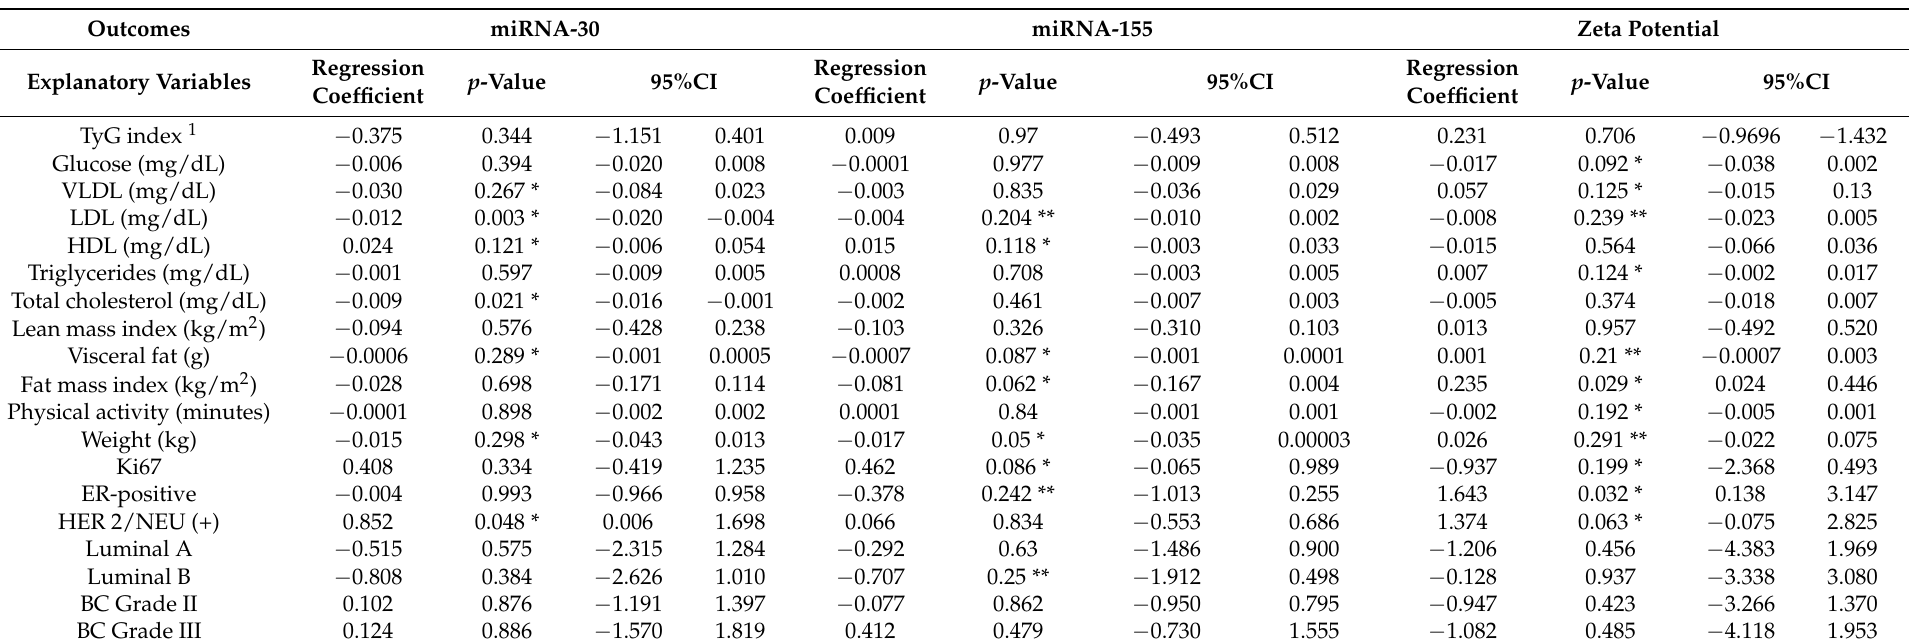
Table 2. Regression analyses using mixed effects models using miRNA-30, miRNA-155, and the Zeta potential as outcome variables in 16 women diagnosed with breast